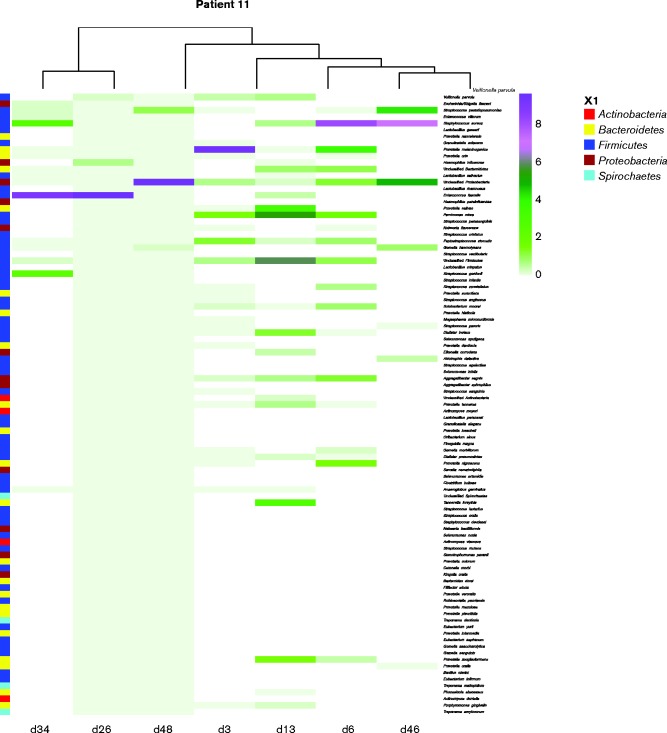
Heat map indicating the level of phyla, species variation and species abundance during MV.